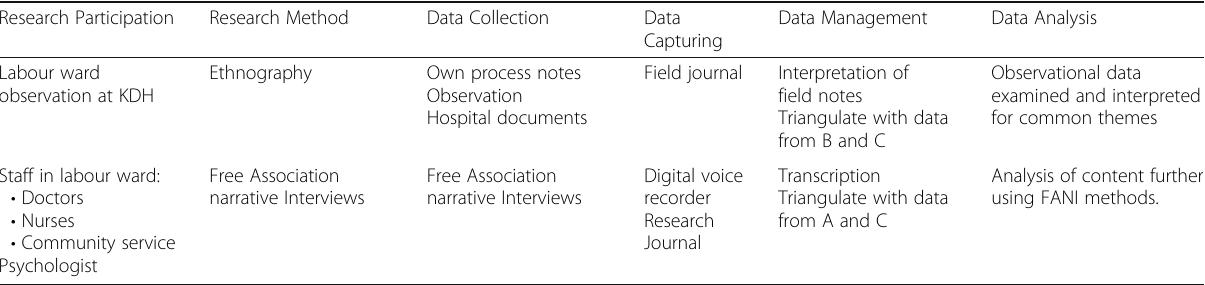
Table 1 Summary of the research methods used in this study Research